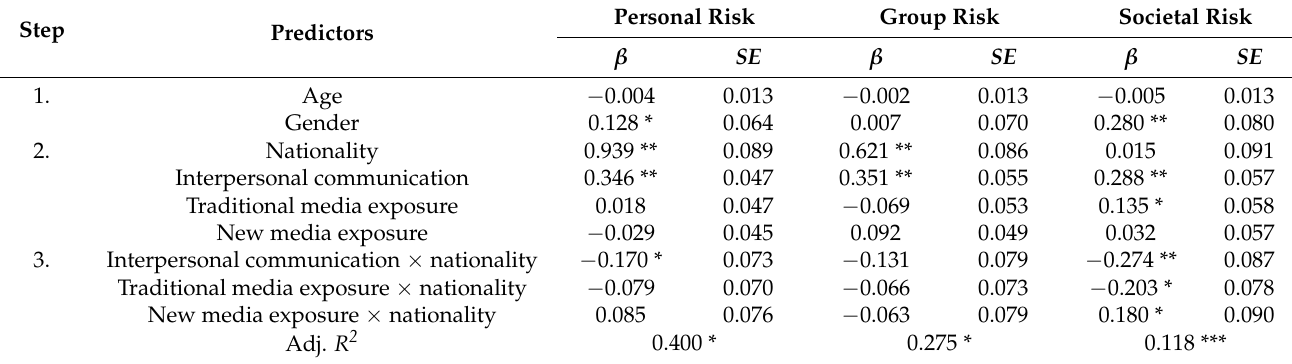
Table 4. Linear regression models on predictors of risk perceptions at three levels.